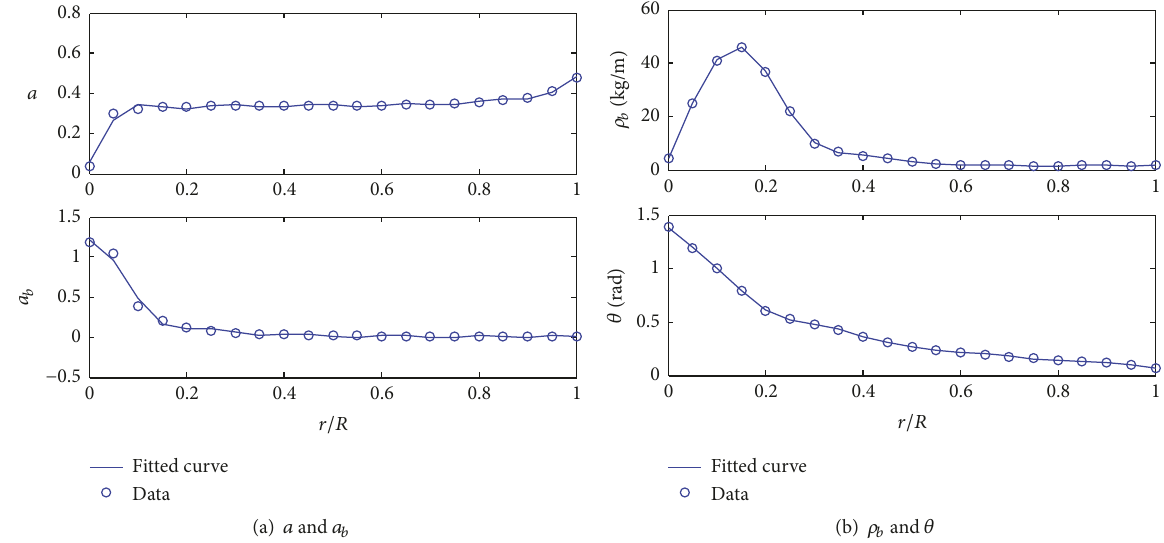
Figure 2: The optimized data of the key parameters and corresponding fitting